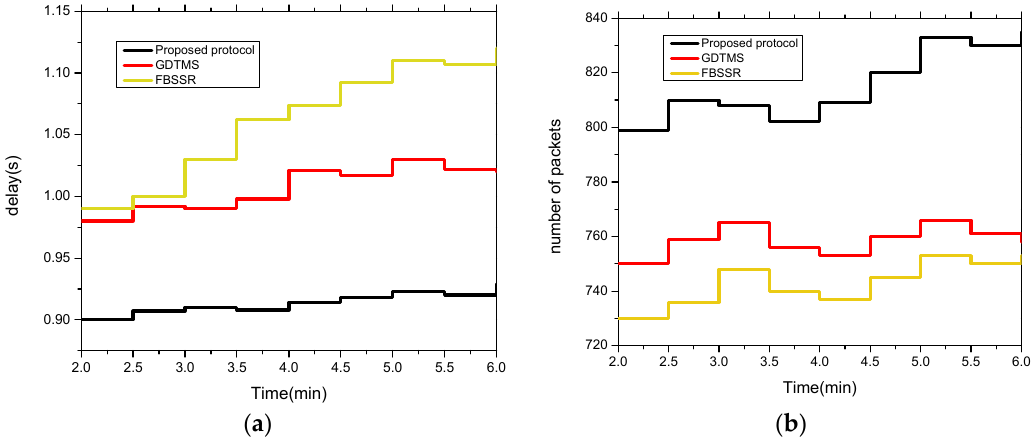
Figure 7. ( a ) Reliability with message generation interval. ( b ) Reliability with mobile devices.